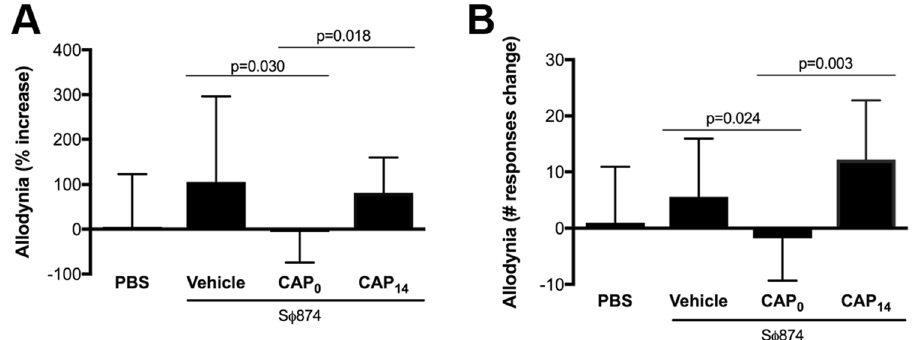
Figure 1. TRPV1 mediates establishment of pelvic allodynia in post-UTI chronic pain. UTIs were induced in female mice by transurethral instillation of E. coli strain S Φ 874 or saline (PBS, n = 13). S Φ 874 infected mice (n = 13) were administered 30 mg/kg capsazepine i.p. at at PID 0 (CAP 0 , n = 13), at PID 14 (CAP 14 , n = 5), or treated with vehicle at PID 0 (n = 13). Mice were then evaluated for allodynia by application of von Frey filaments to the pelvic area at PID 0 and PID 15. Values represent mean ± S.D. ( A ) Reduced allodynia of S Φ 874- infected mice administered capsazapine at PID 0 but not in mice receiving capsazapine at PID 14. The percent change of behavioral responses relative to baseline at PID 0. ( B ) Numerical change in behavioral responses relative to baseline ( * P <